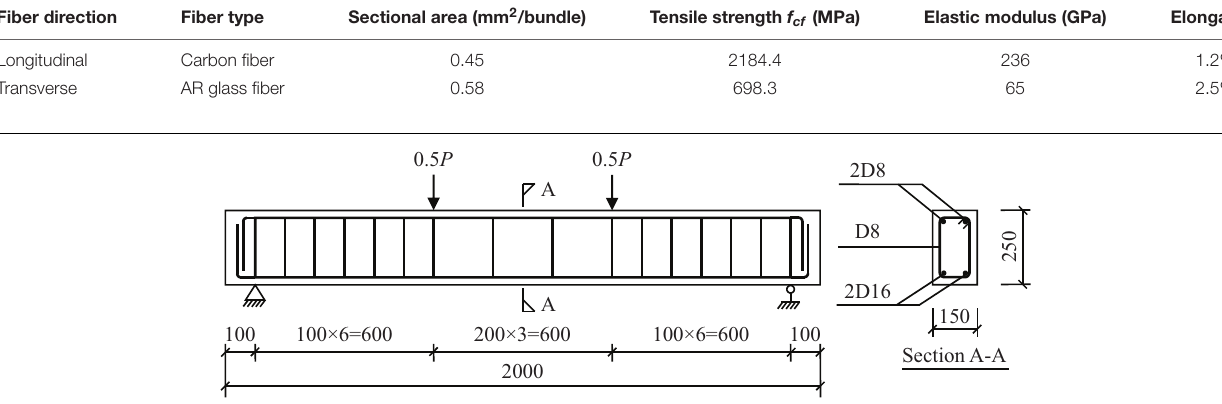
TABLE 2 | Characteristics of textile mesh.